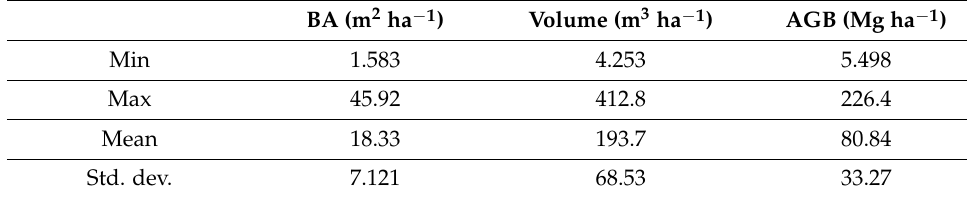
Table 1. Summary statistics of inventory plots.